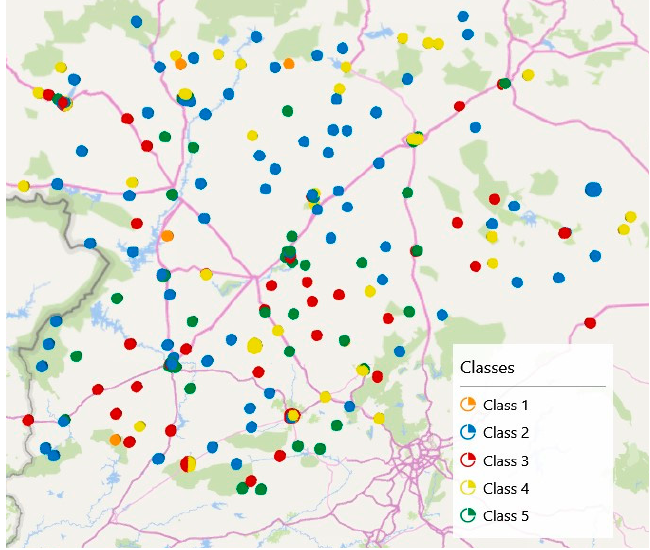
Figure 8. Geographical distribution of the classified buildings.